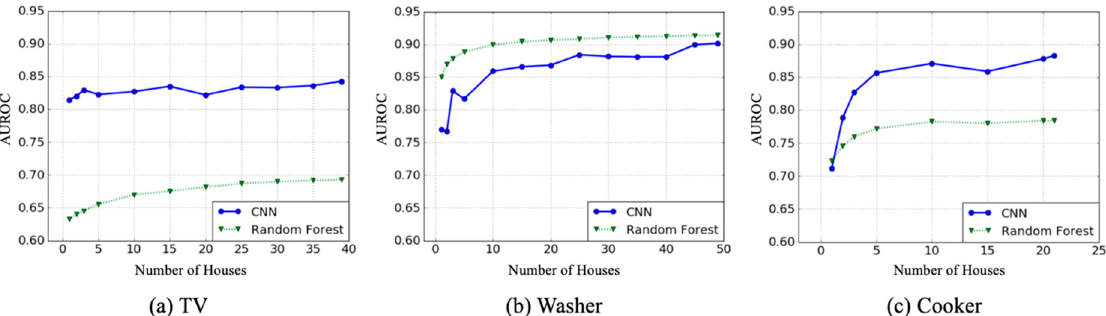
Figure 12. Sensitivity of classification algorithms to the number of distinct houses used in the training data. As the number of houses increases, the test performance tends to improve. Owing to the limitation in the dataset, up to 39, 49, and 21 houses were investigated for TVs, washers, and rice cookers, respectively.